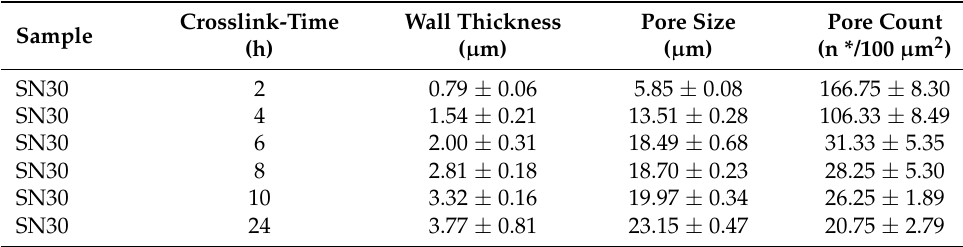
Table 1. Effect of crosslinking time on wall thickness, pore size, and pore count of SN hydrogels prepared with a constant GA content of 30 mL and various crosslinking times.